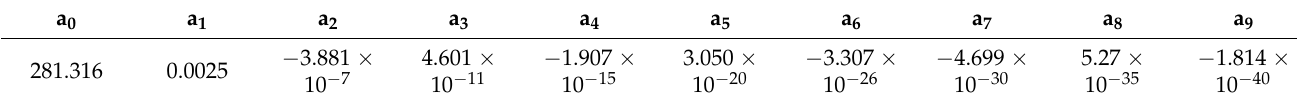
Table 1. The polynomial coefficients of the HTF temperature equation